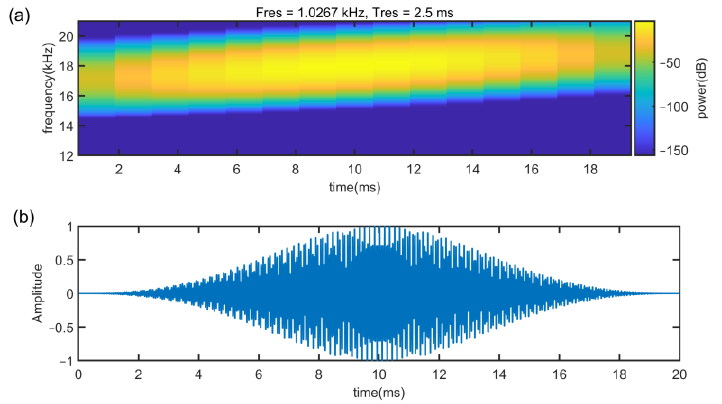
Figure 6. ( a ) The relationship between hearing threshold and frequency, where measured SPL represents the maximum SPL in LFM of 18 kHz – 23 kHz. ( b ) The SPL with distance.